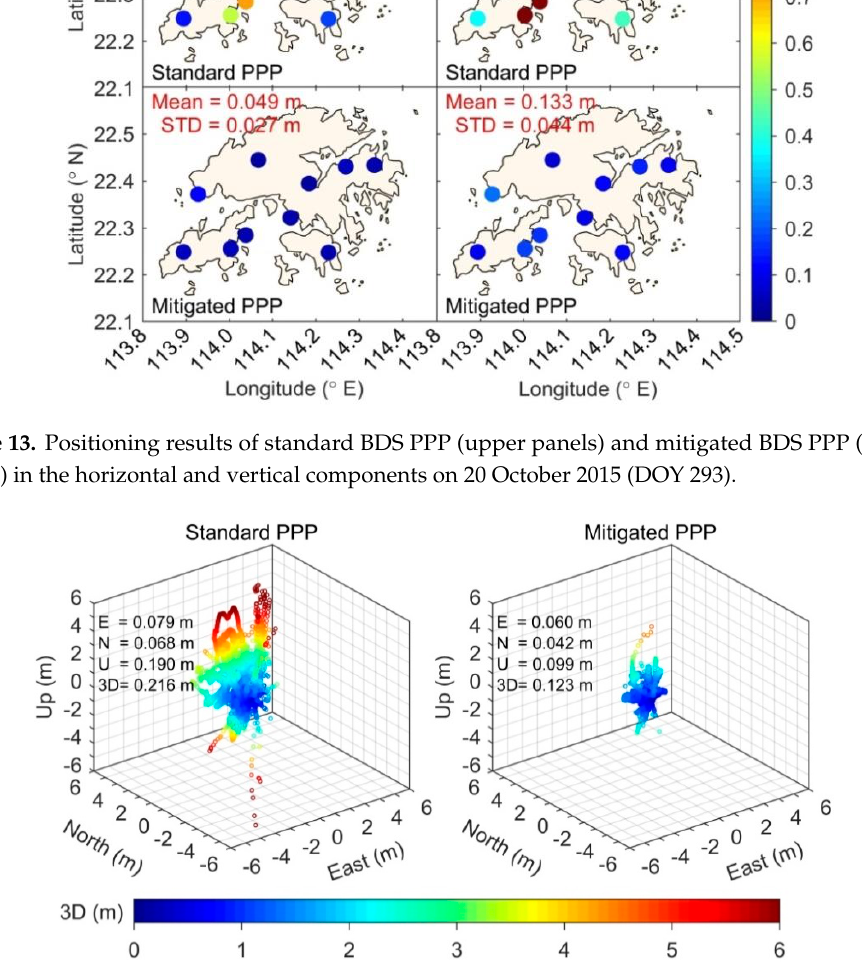
Figure 13. Positioning results of standard BDS PPP (upper panels) and mitigated BDS PPP (bottom panels) in the horizontal and vertical components on 20 October 2015 (DOY 293).